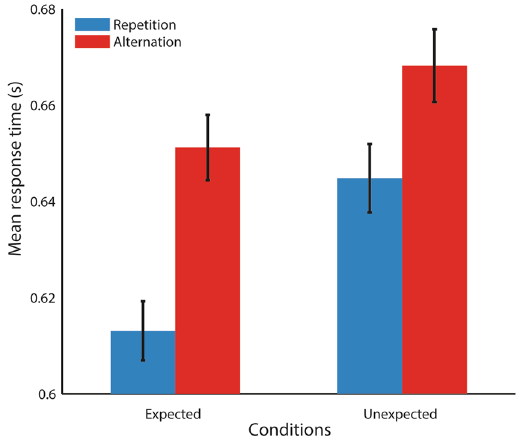
Figure 2. Reaction times during category discrimination task (preceding the fMRI experiment). Error bars reflect within-subject standard error of the mean (SEM) 46, 47 . There were significant main effects of repetition and expectation. Additional information about responses can be found in supplemental Figure